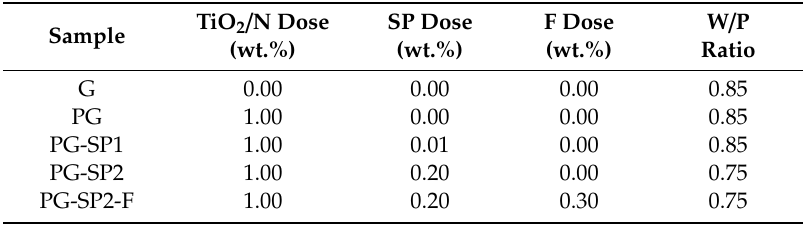
Table 3. Compositional date for the selected gypsum plasters. Sample